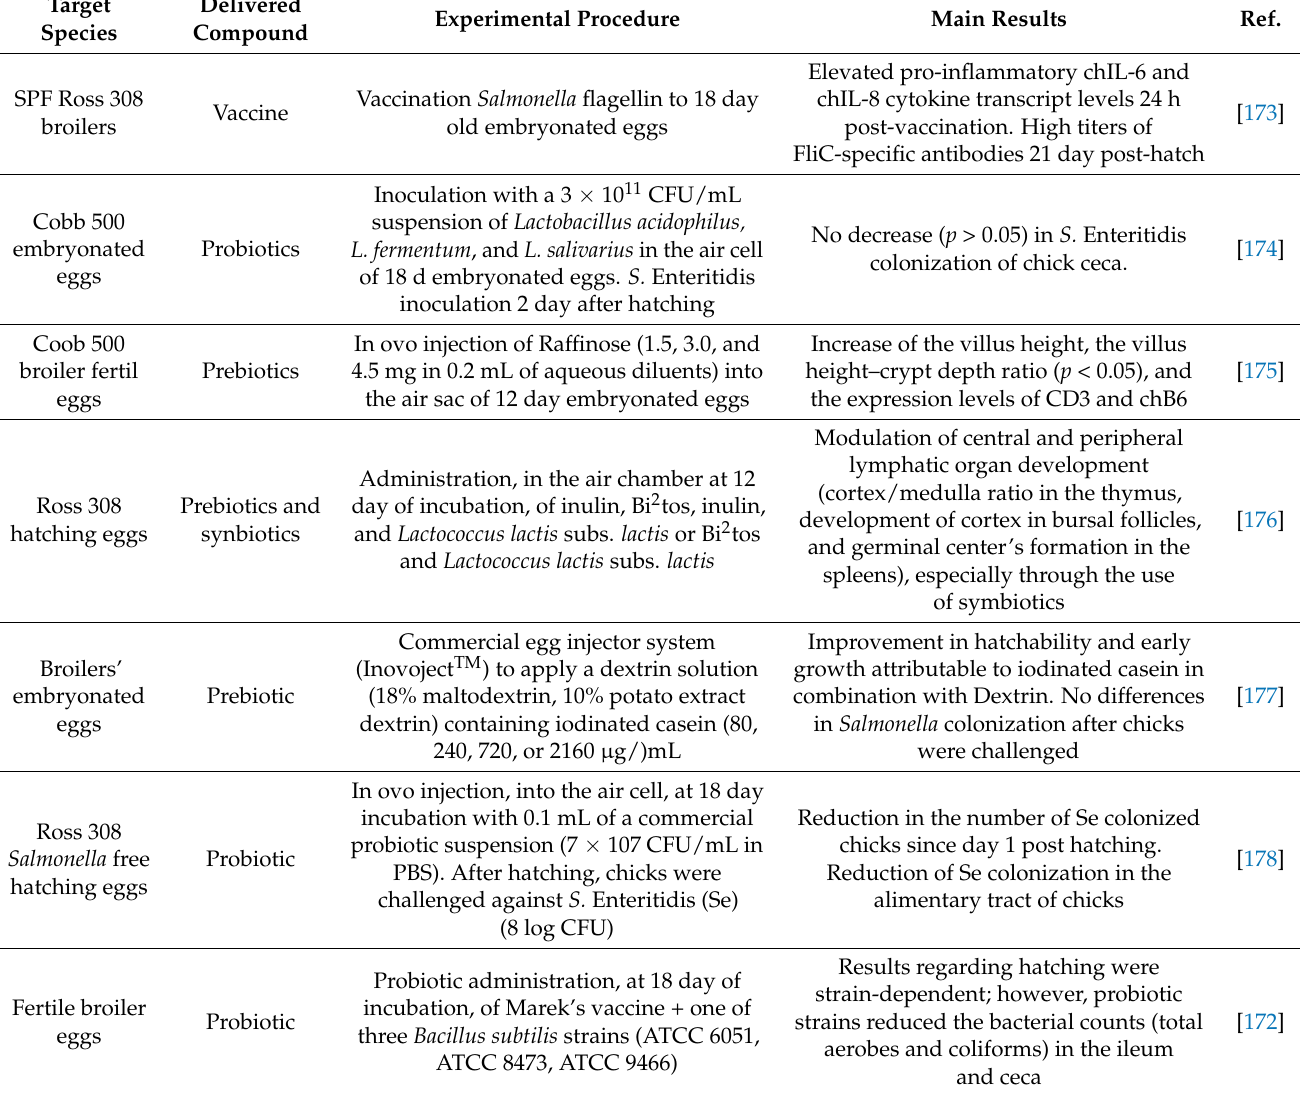
Table 8. In ovo alternatives to control Salmonella infection in